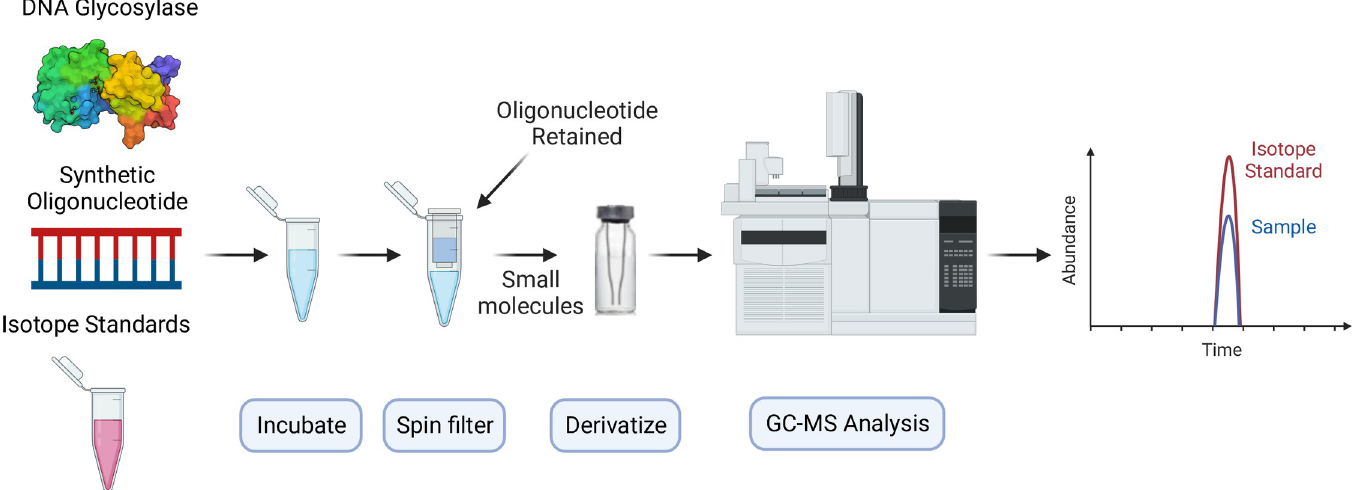
Fig 5. GC-MS scheme. This workflow illustrates the GC-MS based glycosylase assay to determine excision and base release from a synthetic oligonucleotide using stable- isotope standards.